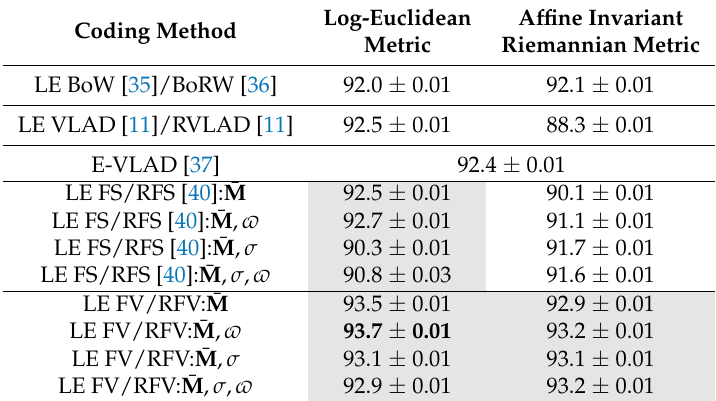
Table 4. Classification results on the Brodatz database (112 classes).